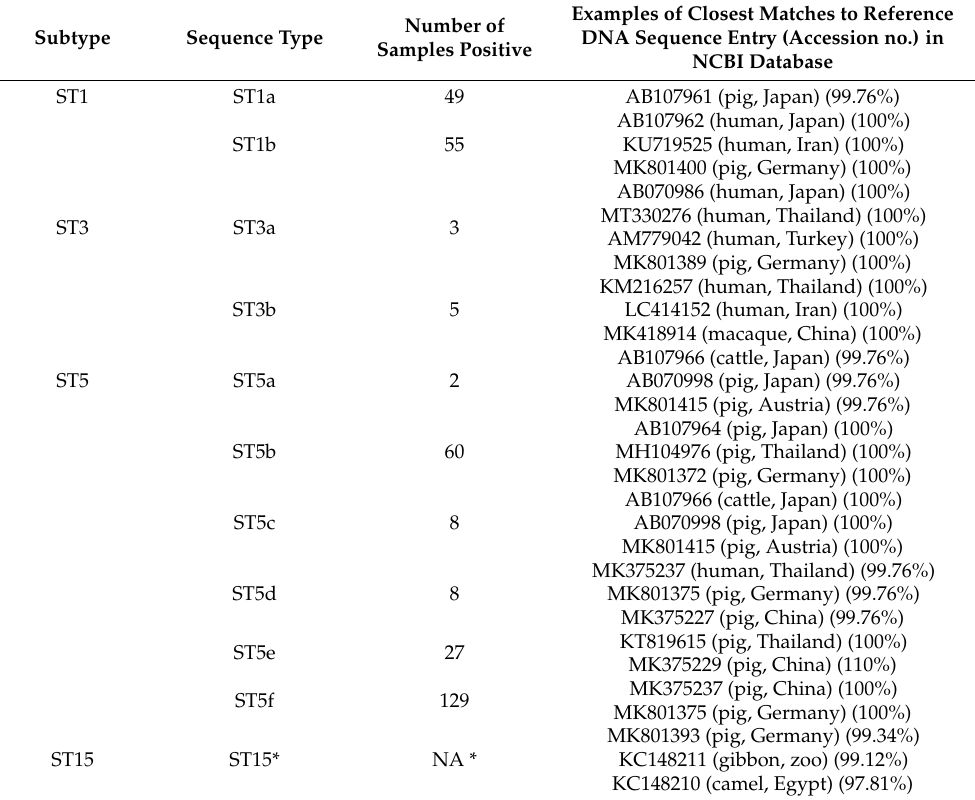
Table 6. Sequence types of Blastocystis subtypes 1, 3, 5, and 15 observed in the present study. Examples of Closest Matches to Reference Number of Subtype Sequence Type DNA Sequence Entry (Accession no.) Samples Positive